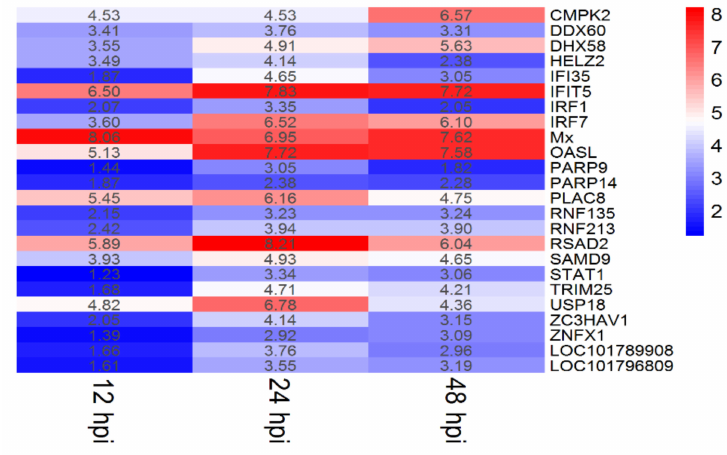
Figure 2. Di ff erentially expressed genes (DEGs) identified at 12, 24, and 48 hpi. ( A ) Numbers of upregulated and downregulated genes at 12, 24, and 48 hpi. ( B ) Venn diagram of DEGs at 12, 24, 48 hpi. The image shows The numbers of common and unique DEGs.